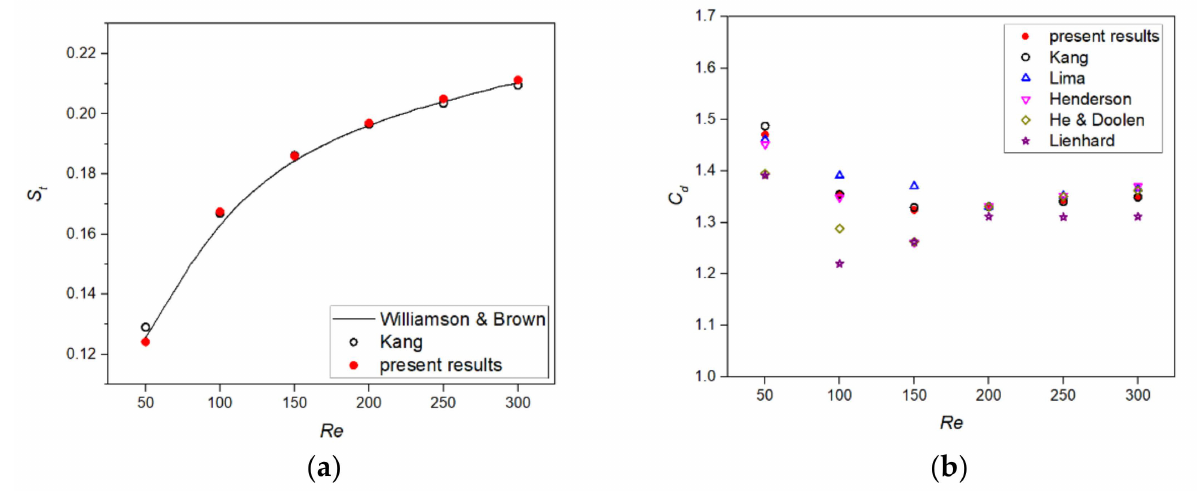
Figure 4. ( a ) S t versus Re . • , present results; Figure 1. ( a ) Schematic diagram of the movement boundary; ○ , fluid grid points; ● , solid grid points; ● , the points that make up the boundary; ☆ , the intersection points of the solid boundary and the intersecting grid; the solid black line is the solid boundary curve; 1-1, 2-2, 3-3, and 4-4 are fixed positions respectively; ( b ) Schematic diagram of discrete velocity of D2G9